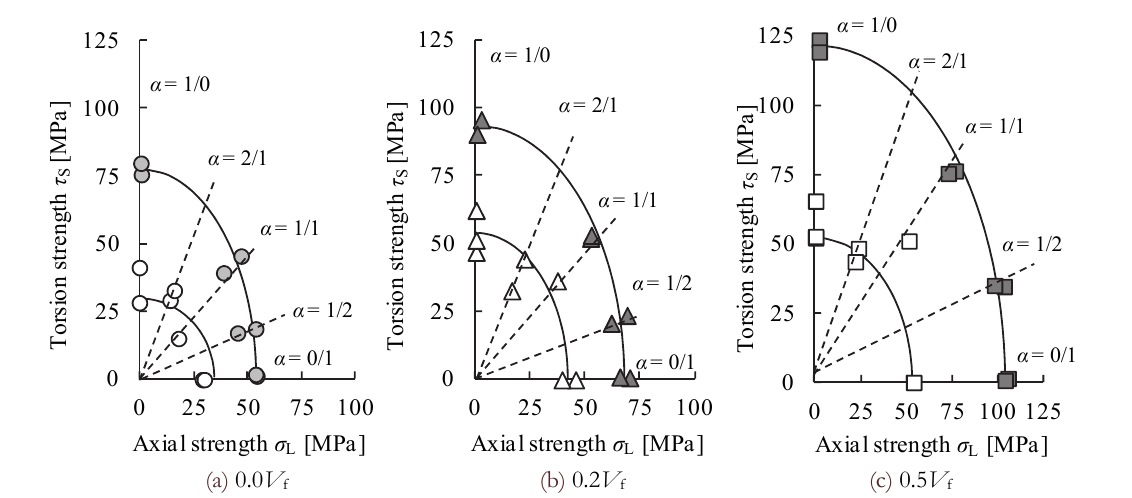
Figure 2: Multiaxial static strength evaluation with Tsai-Hill failure rule.